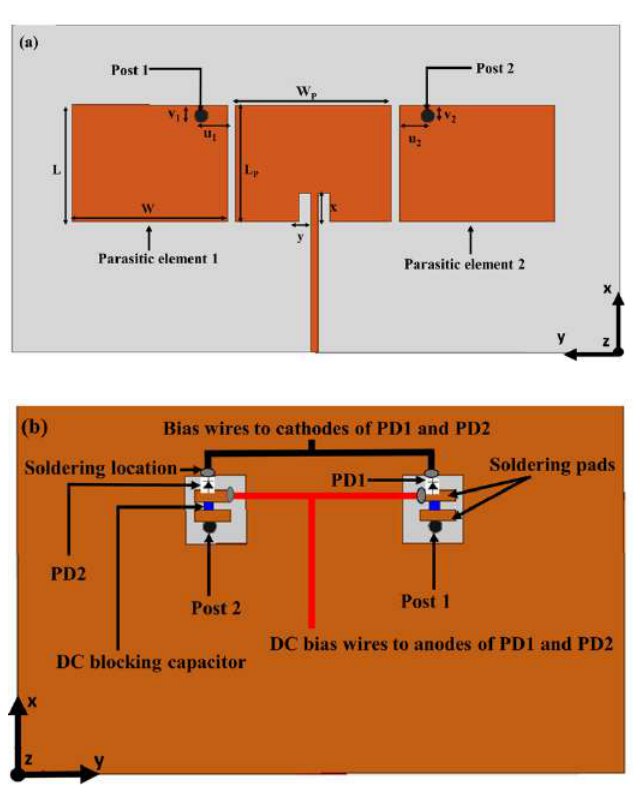
FIGURE 2. (a) Top, and (b) Bottom view of initial antenna